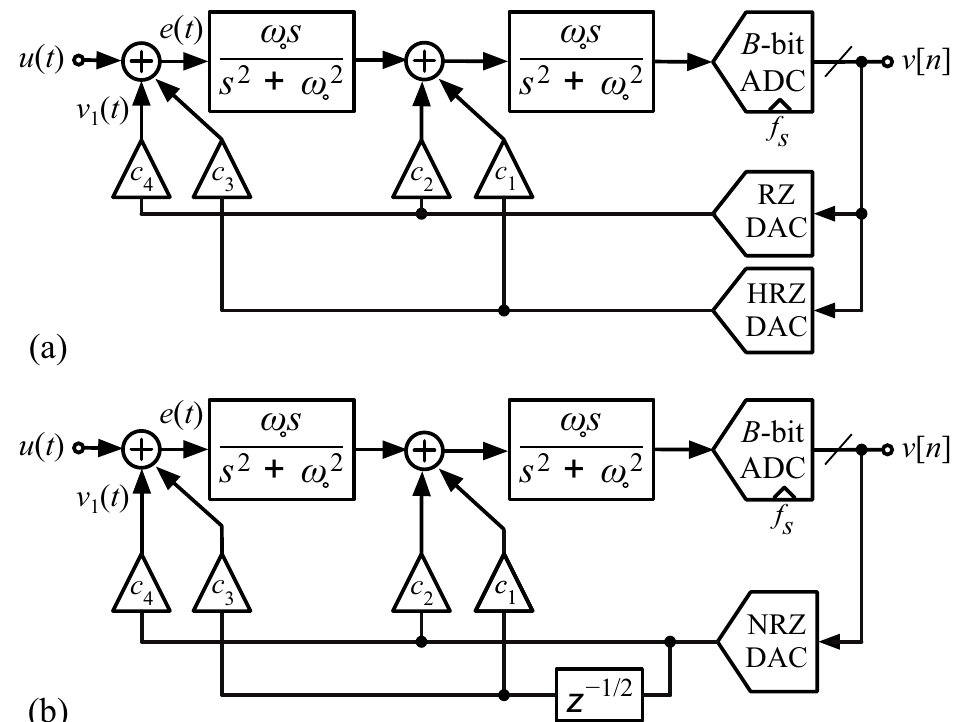
Figure 10. Conventional LC BP- Σ∆ Ms with a multi-path feedback loop based on the following: ( a ) Different DAC (RZ/HRZ) waveforms [50]. ( b ) Identical DAC (NRZ) with different delay